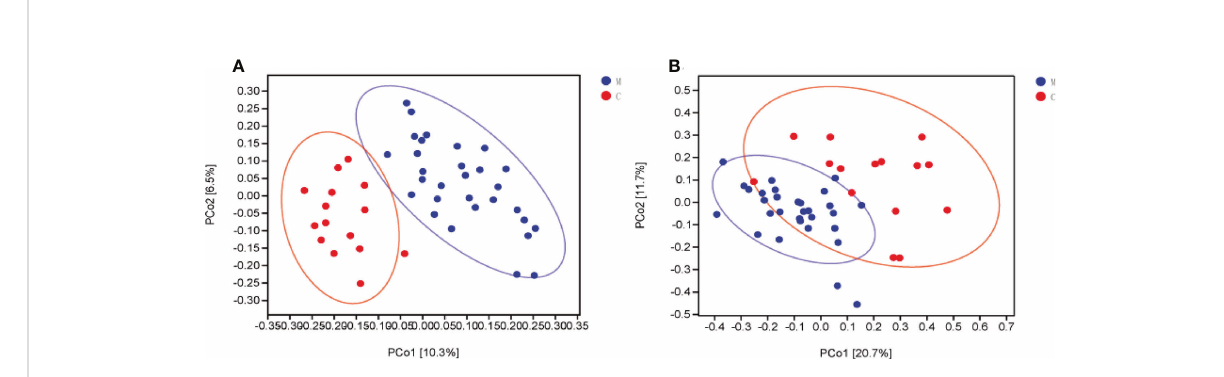
FIGURE 2 Dental plaque microbiota composition is altered in group M (methamphetamine using). (A, B) Principal coordinate analysis (PCoA) of bacterial beta diversity based on unweighted (A) and weighted (B) UniFrac distances.